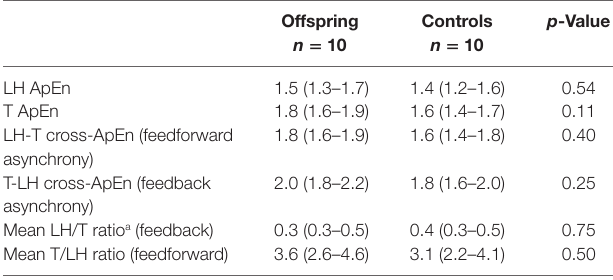
TaBle 3 | Proxies of feedforward and feedback regulation of lh and testosterone (T) secretion in male offspring of long-lived families and controls.